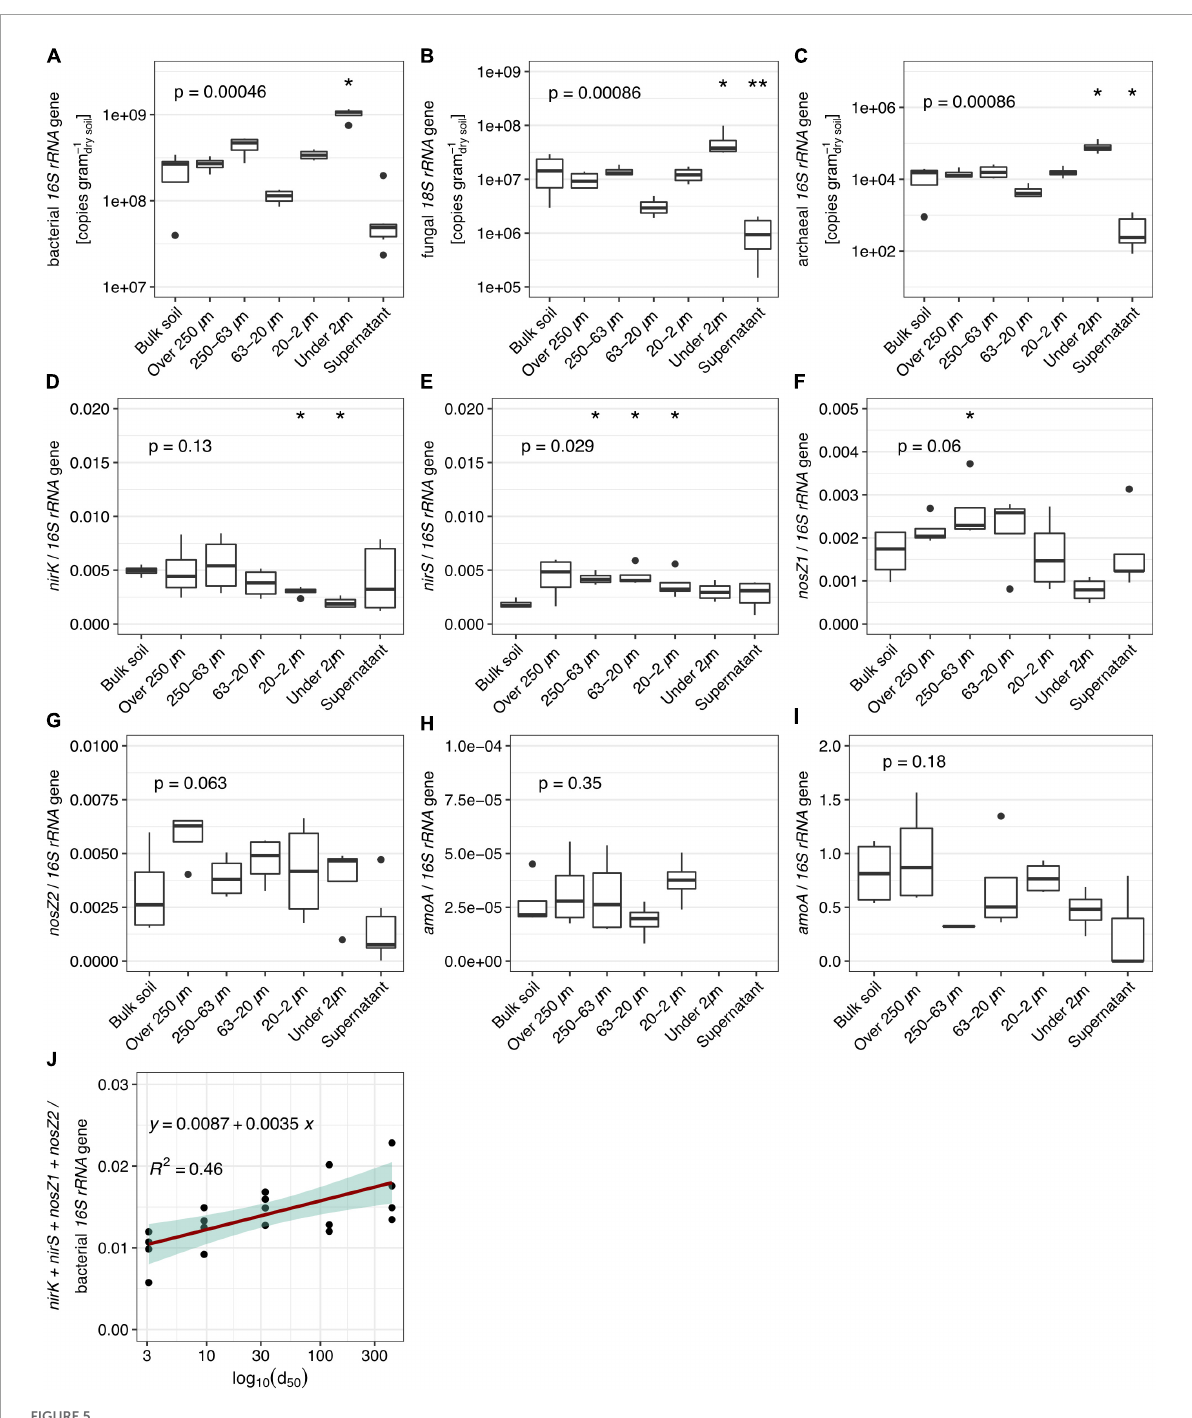
FIGURE5 Abundance estimated by quantitative PCR ( n = 6) of bacterial, fungal, and archaeal SSU rRNA genes [ (A–C) , respectively] and ratios of various nitrogen cycling maker gene abundances in obtained fractions and bulk soil. (D,E) Nitrite reductases to bacterial SSU rRNA. (F,G) Nitrous oxide reductases to bacterial SSU rRNA. (H) Ammonia oxidizing bacteria to bacterial SSU rRNA. (I) Ammonia oxidizing archaea to bacterial SSU rRNA. (J) Linear regression ( p -value = 0.026) of ratio of summed up reductive N-cycle marker to bacterial SSU rRNA. Values presented in the supernatant group were obtained by calculating the amount washed-off DNA from 1 g of soil during the fractionation procedure to allow comparison. P -values correspond to non-parametric ANOVA Kruskal–Wallis tests. Asterisks indicate significance from Wilcoxon tests between the sample group and bulk soil samples (* and ** stand for alpha = 0.05 and 0.01,